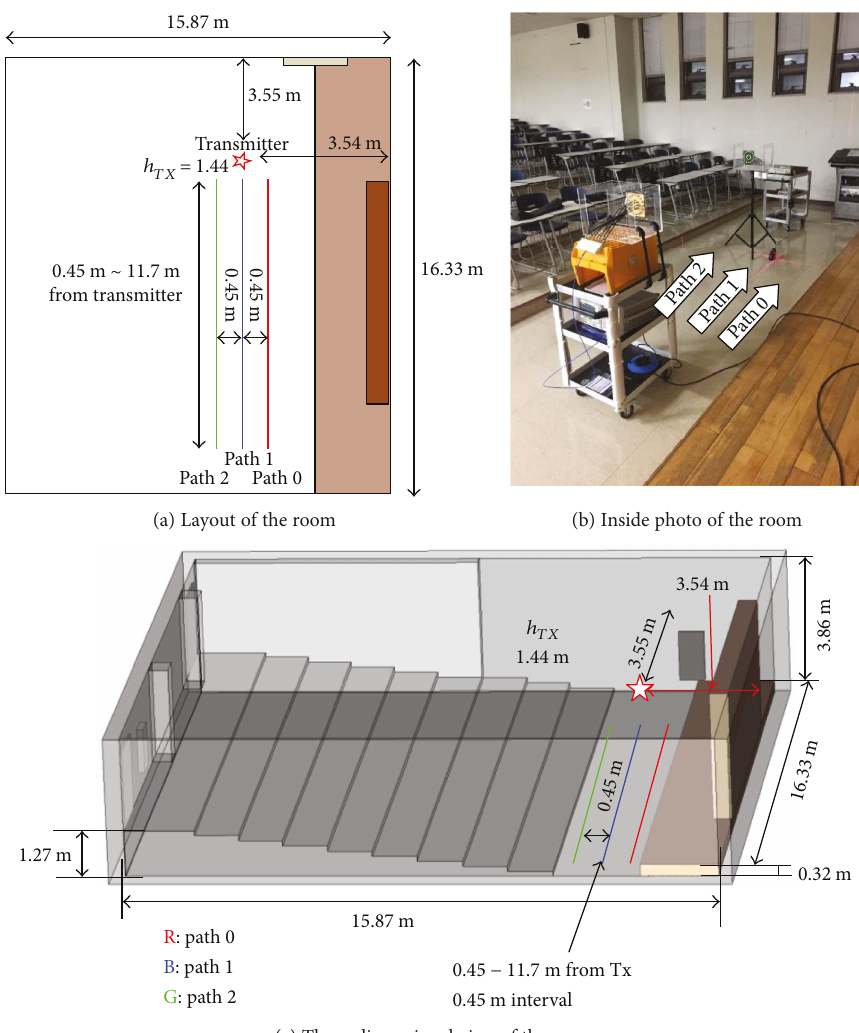
Figure 3: Measurement site (lecture